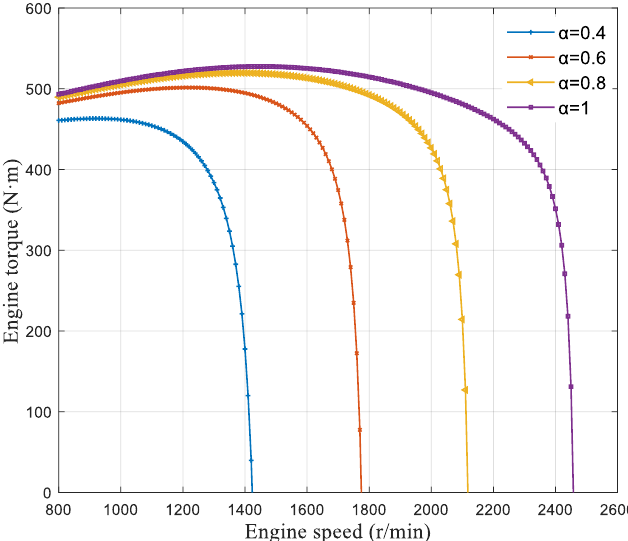
Figure 6. Engine speed-regulation characteristic diagram.